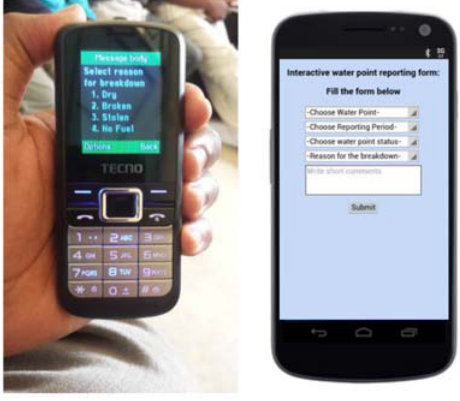
Figure 1. SEMA App version 3.